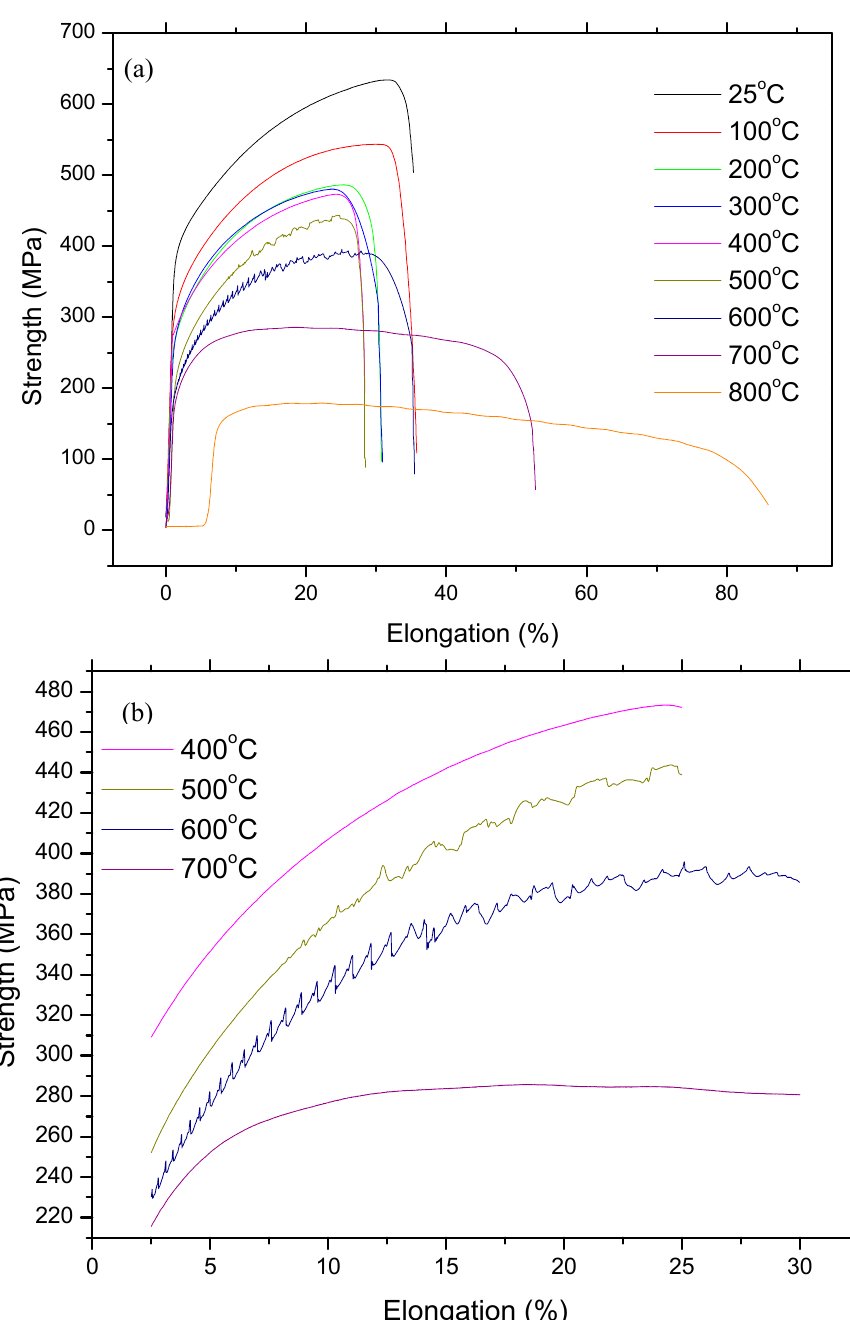
Figure 4. Stress and strain diagrams of as-received samples: ( a ) full range profiles and ( b ) sections in large scala.